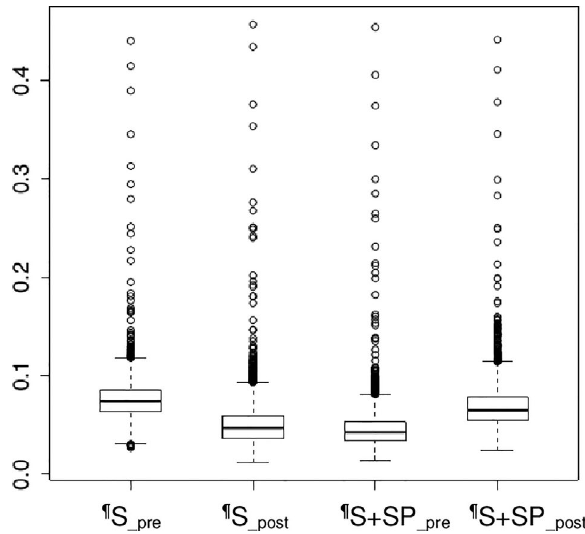
Figure 5 - Box plot of the posterior probability of volleyball ‘stuff block’ in the Skill (S) and Skill and strength/power (S+SP) groups in the pre- and post-training assessments